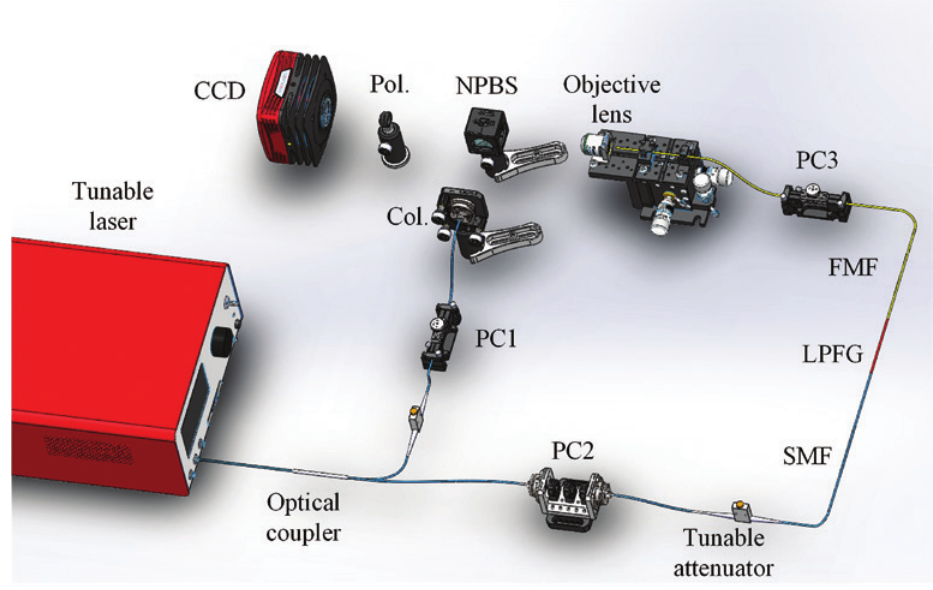
Figure 4: Experimental setup for the generation and detection of high-order spatial states. PC, polarization controller; SMF, single mode step index fiber; FMF, few modes step index fiber; LPFG, long period fiber grating; Col., collimator; NPBS, non-polarization beam splitter; Pol., polarizer; CCD, charge coupled